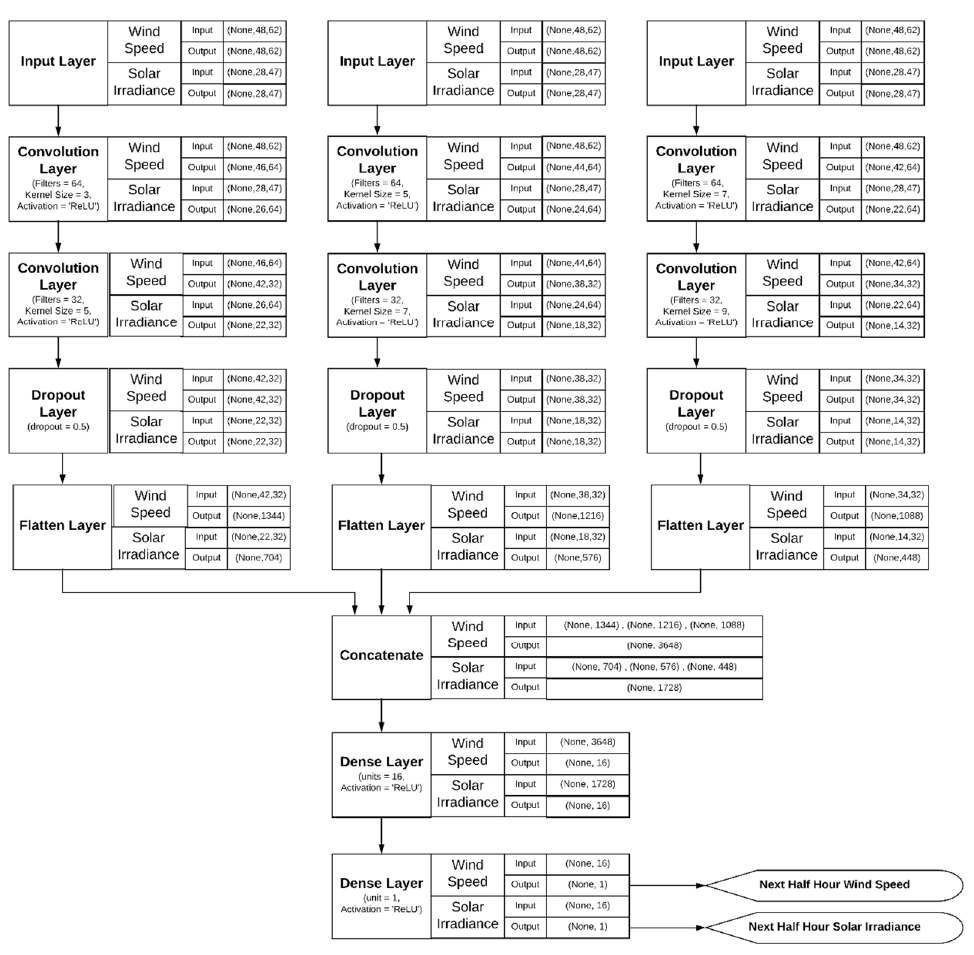
Figure 5. Structure of proposed MH-CNN model.